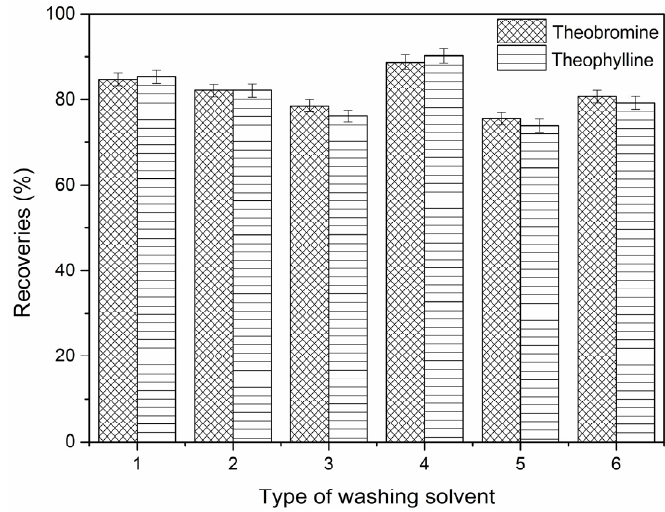
Figure 6. Effect of washing solvents for theobromine, and theophyline (1: MeCN; 2: EtOH; 3: H 2 O; 4: MeOH; 5: EtOAc; 6: Acetone).